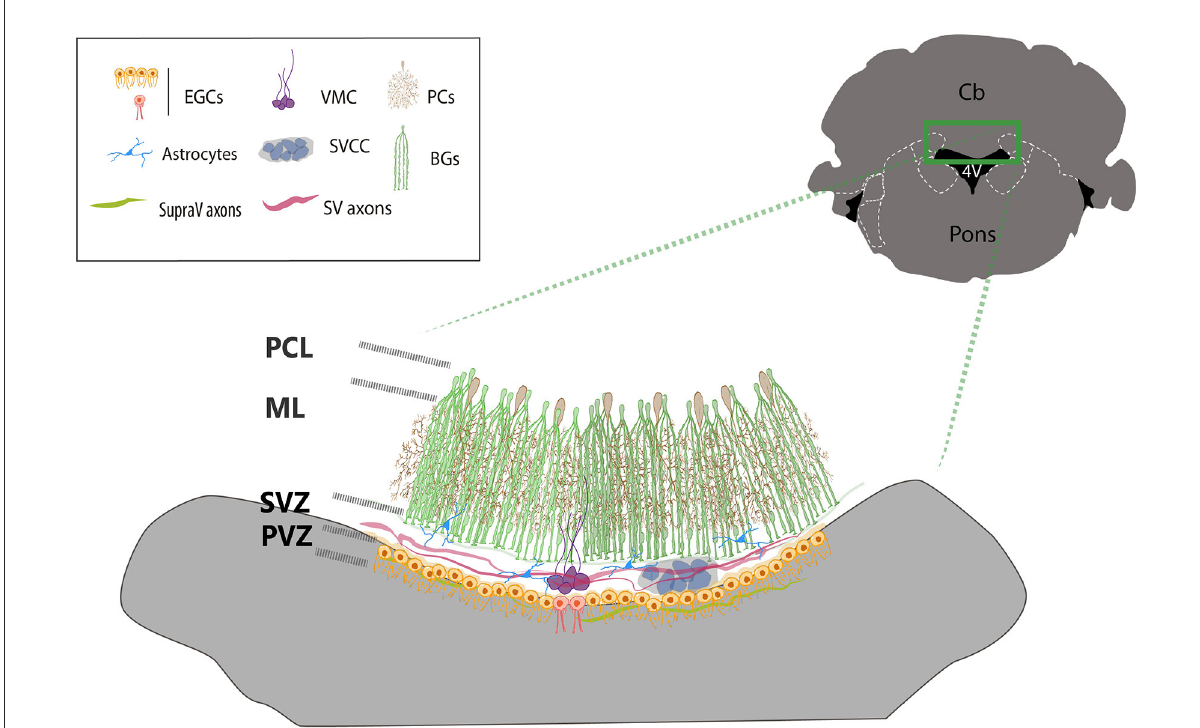
FIGURE3 Cellular organization of the ventricular zone of the cerebellum. The drawing summarizes the main cell types found in the roof of the 4V. BG cells (green) surrounds and covers the dendritic trees of Purkinje neurons (brown). The end-feet of Bergmann glia borders the dorsal side of the SVZ, where the subventricular cellular cluster is located (SVCC, gray blue) which is ventrally bordered by multiciliated ependymal glial cells (orange cells). The ventromedial cord (VMC, purple), is integrated by local subventricular neurons and glial cells and contacted by local astrocytes (blue). Ependymal biciliated cells (red) are in the midline at the periventricular layer-zone (PVZ), facing the lumen of the ventricle. Two sets of axons transverse contralaterally the roof of the 4V, subventricular axons (SV axons, red) from the fastigial nucleus and supraventricular axons (SupraV axons, green) form the vellum medularis that project from the IV cranial